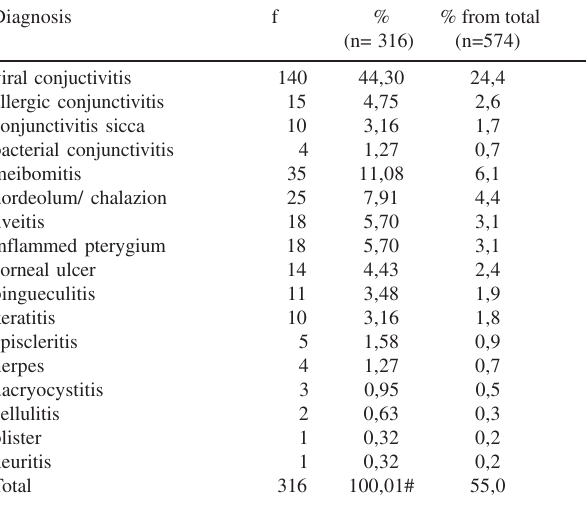
Table 2 - Patients with inflammation and infection diagnostics that looked for ophthalmology emergency room of the University of São Paulo Medical School General